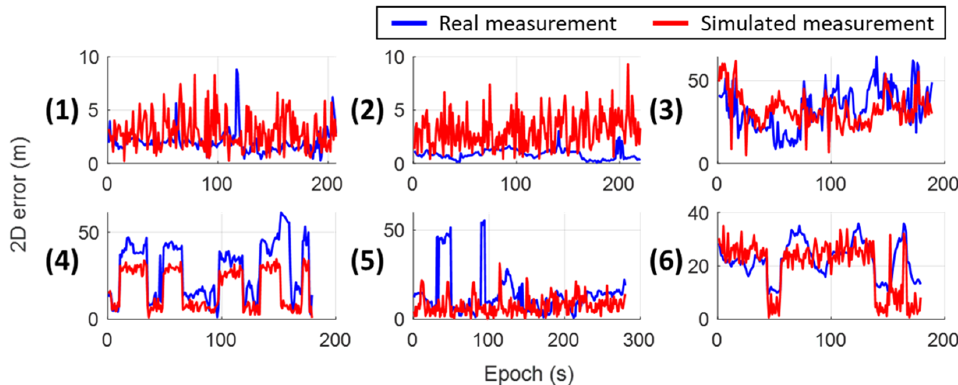
Figure 22. The least squares positioning 2D errors of different agents based on the simulated and real measurements during the multiagent experiment. The number is corresponding to the agent index in Figure 21. Table 5. The 2D positioning RMSE (in meter) from the simulated and real measurements of different agents during the multiagent experiment.